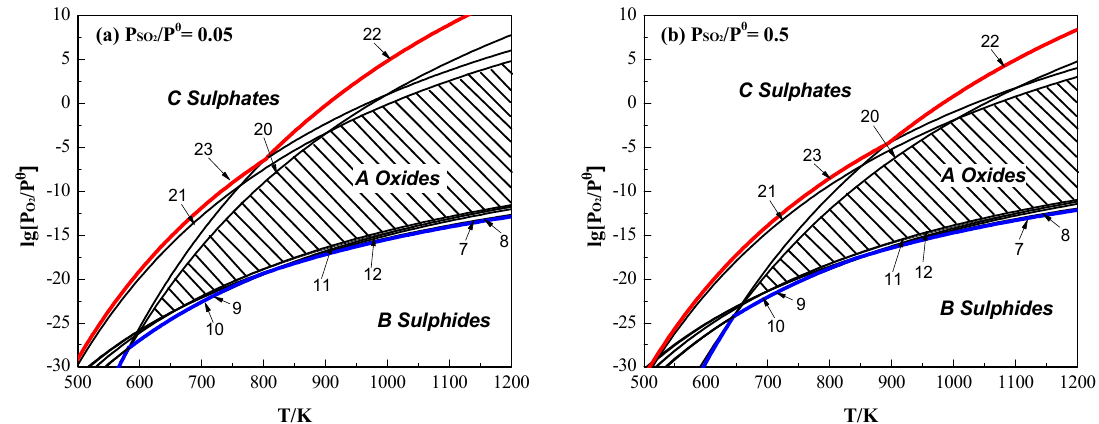
Figure 4. E ff ects of O 2 and T on the roasting of pyrite as a function of lg[P O2 / P θ ] and T under ( a ) P SO2 / P θ Figure 4. Effects of O 2 and T on the roasting of pyrite as a function of lg[P O 2 /P θ ] and T under ( a ) = 0.05 and ( b ) P / P θ = P SO 2 /P θ = 0.05 and ( b ) P SO 2 /P θ = 0.5. SO2